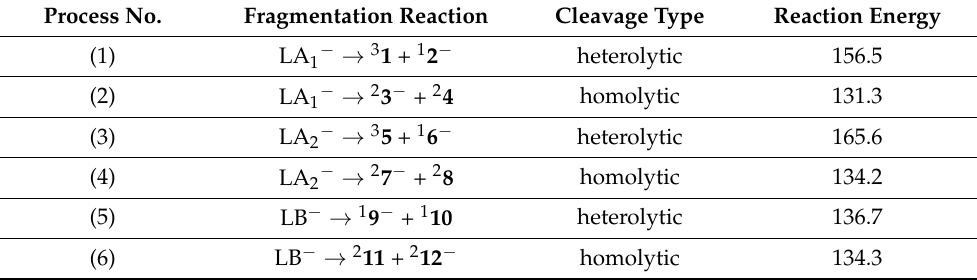
Table 2. Reaction energies (in kcal/mol) corresponding to the homolytic and heterolytic fragmen- tations depicted in Figure 9. The results are obtained by employing the B3LYP method and the 6-311++G(d,p) basis set. Process No. Fragmentation Reaction Cleavage Type Reaction